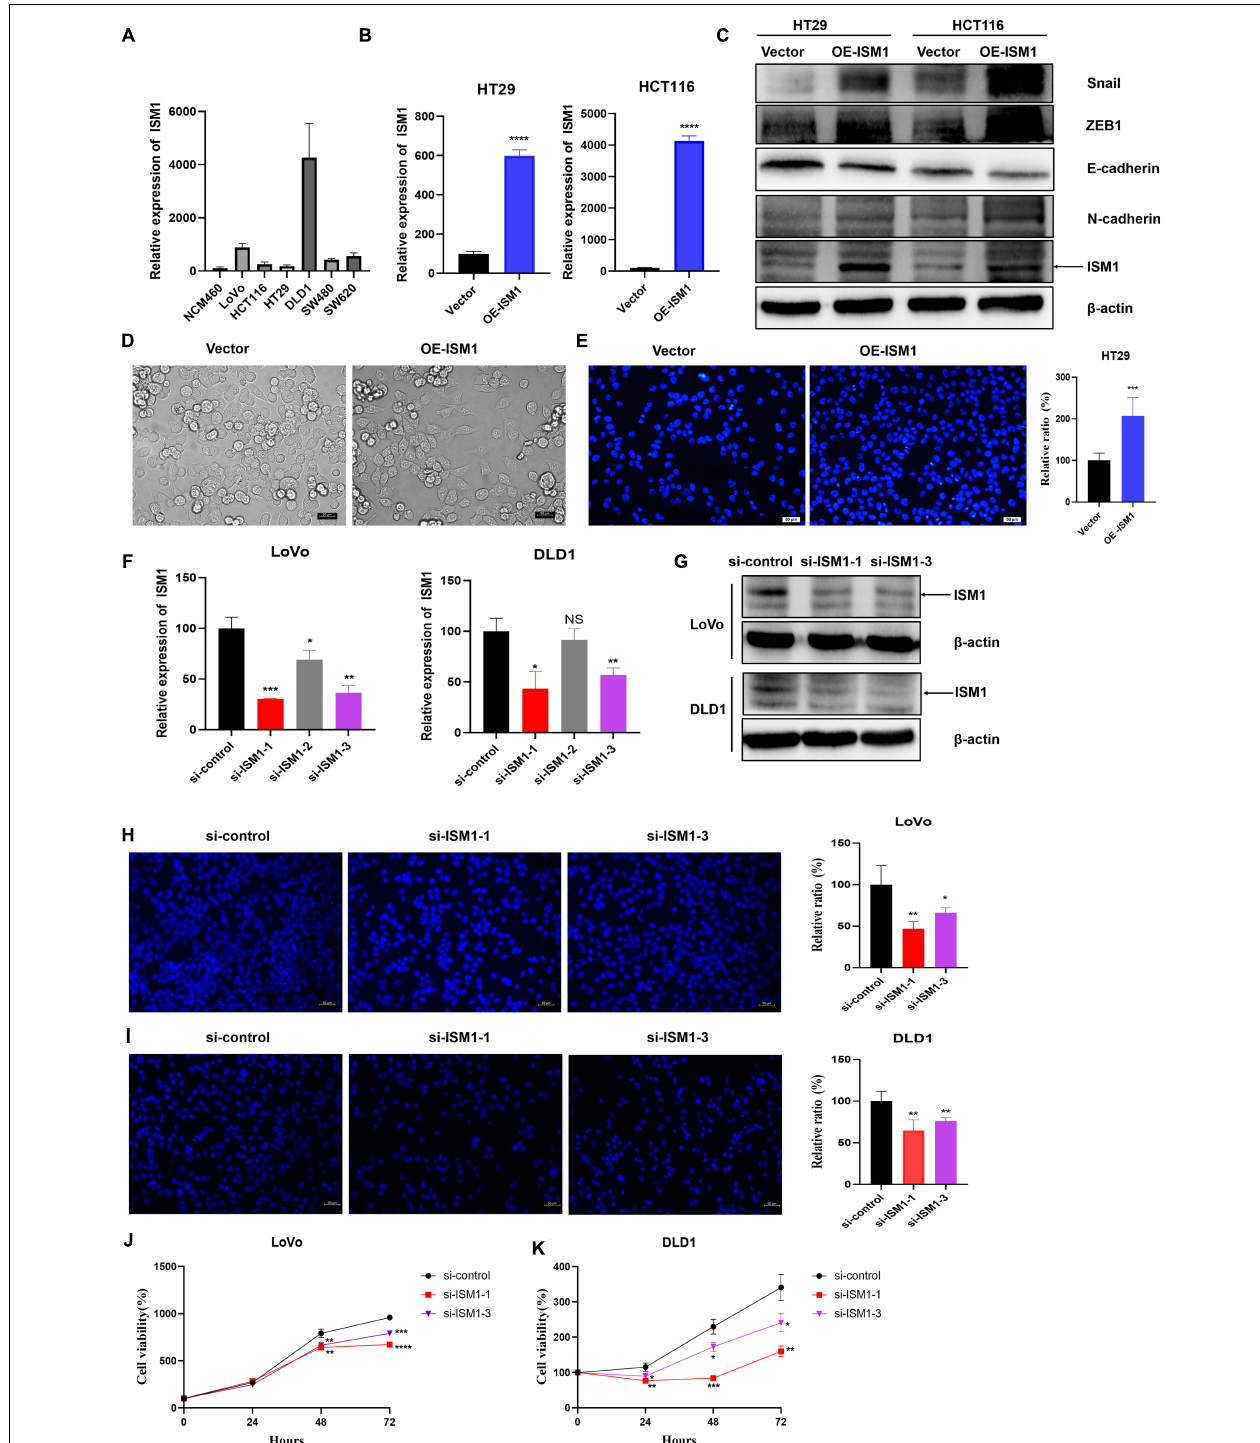
FIGURE 7 | ISM1 promotes EMT and CRC progression in vitro . (A) Quantitative reverse transcription polymerase chain reaction (qRT-PCR) analysis of ISM1 mRNA levels in NCM460, LoVo, HCT116, HT29, DLD1, SW480, and SW620 cells ( n = 3, mean ± SD). (B) The overexpression (OE) efficiency of ISM1 plasmid (OE-ISM1) in HT29 and HCT116 cells was analyzed via qRT-PCR. Student’s t test; **** P < 0.0001; n = 3, mean ± SD. (C) Immunoblot analysis of ISM1, N-cadherin, E-cadherin, Snail, and ZEB1 in HT29 and HCT116 cells transfected with Vector or OE-ISM1 plasmid. (D) Phase contrast images of HT29 cells transfected with Vector or OE-ISM1 plasmid. Scale bars: 50 µ m. (E) Transwell assay of HT29 cells transfected with Vector or OE-ISM1 plasmid. Student’s t test; ** P < 0.01; n = 5, mean ± SD. Scale bars: 50 µ m. (F) The knockdown efficiency of si-ISM1-1, si-ISM1-2 and si-ISM1-3 in LoVo and DLD1 cells was analyzed via qRT-PCR.